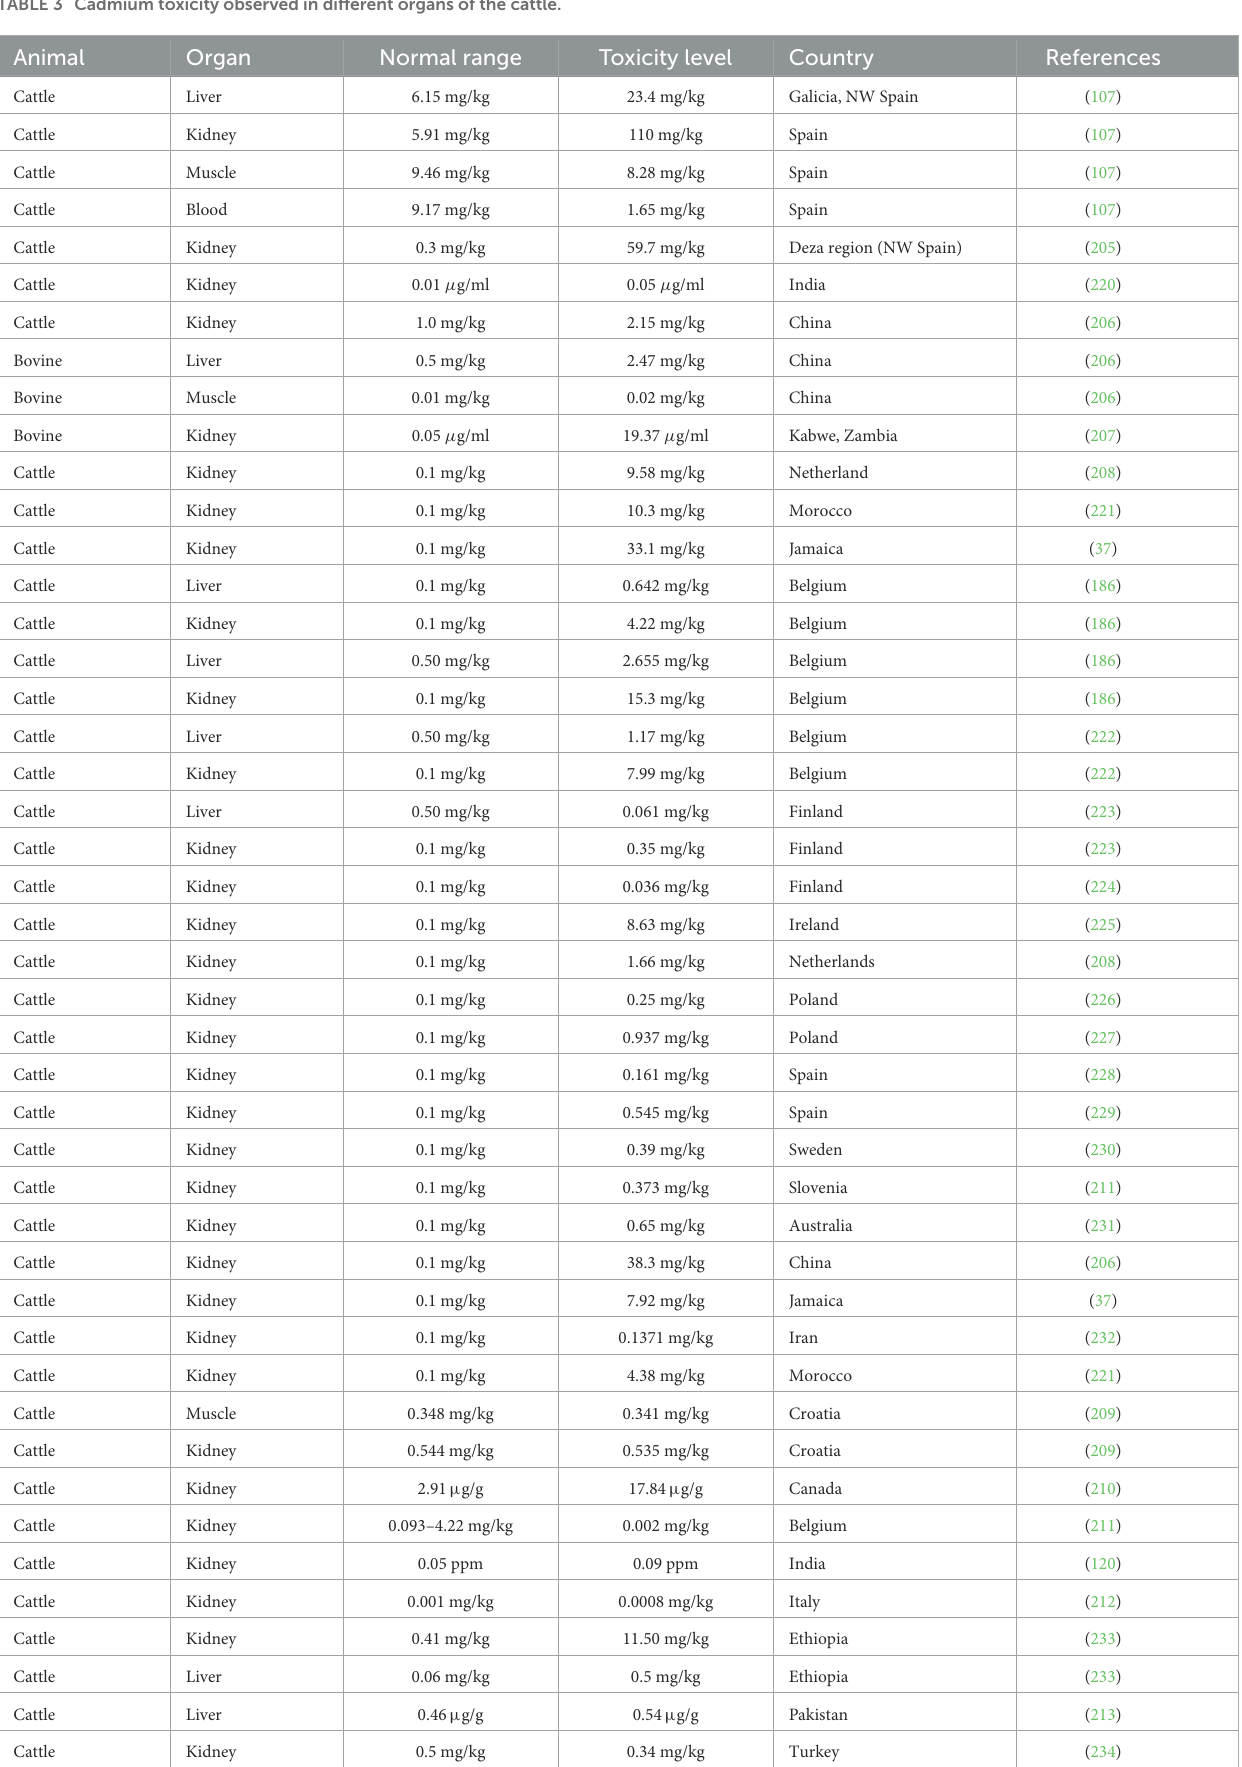
TABLE 3 Cadmium toxicity observed in different organs of the cattle. Animal Organ Normal range Toxicity level